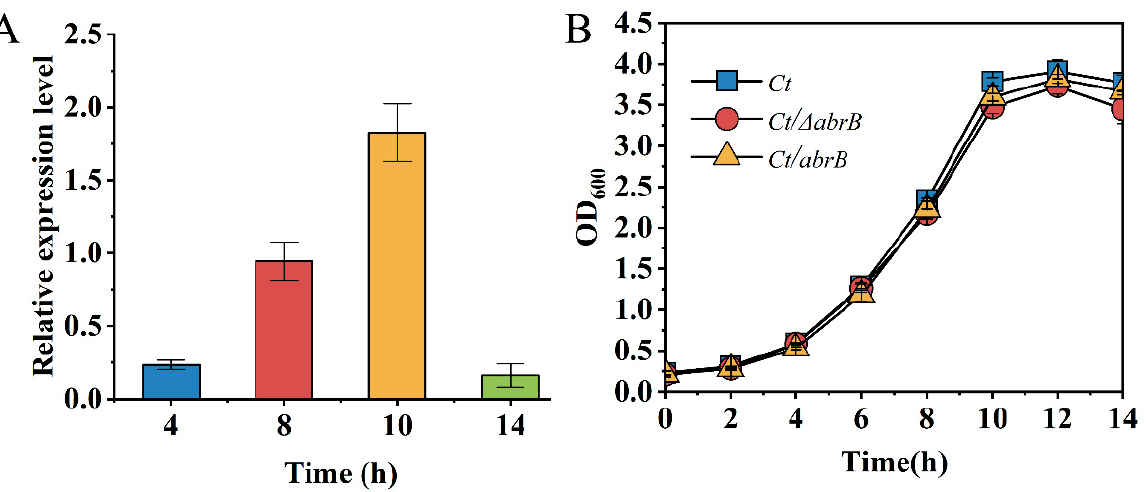
Figure 2. Characteristics analysis of AbrB in C. tyrobutyricum . ( A ) Growth phase-dependent abrB gene transcriptional profile; ( B ) Growth curves of Ct , Ct/ ∆ abrB , Ct/abrB and Ct/ ∆ abrB-abrB strains.